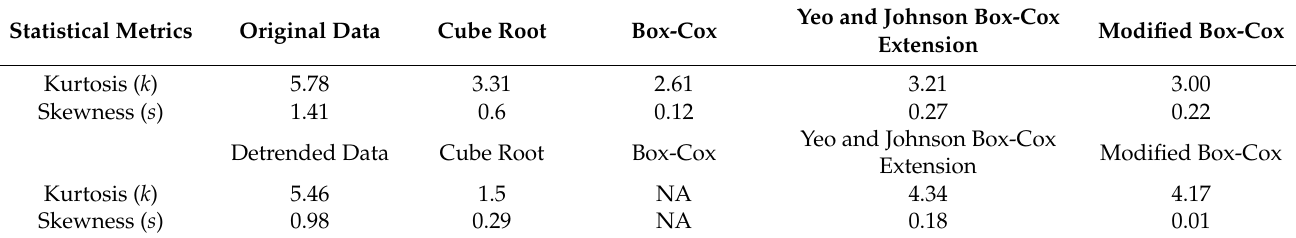
Table 2. Gaussianity metrics of the tested rainfall